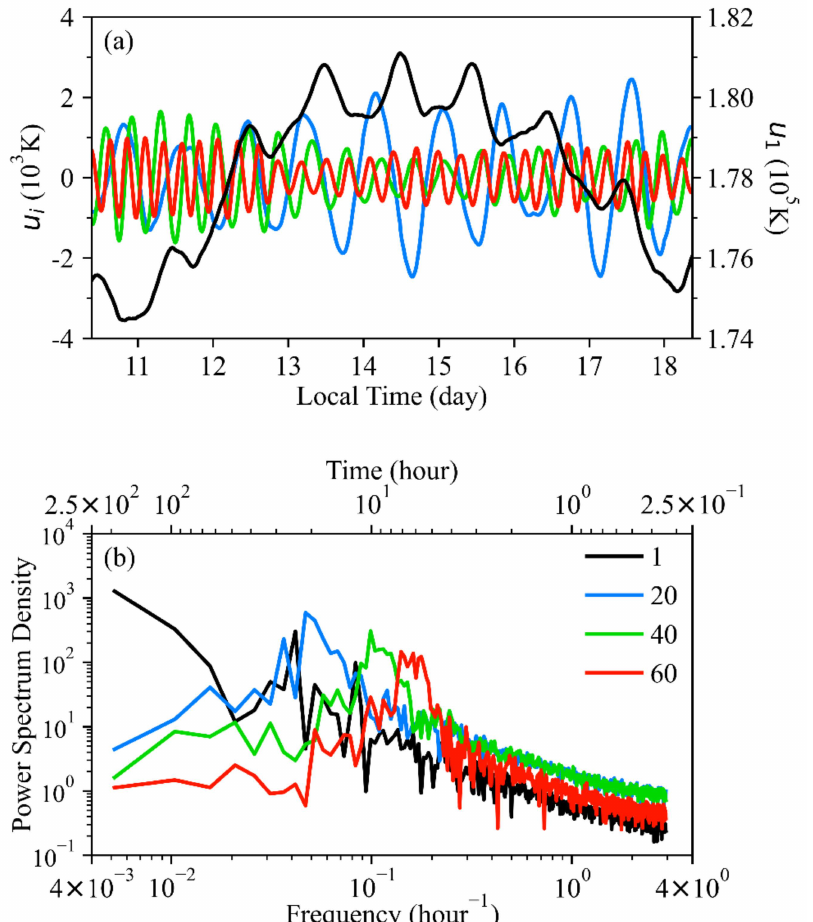
Figure 7. The first (black), 20th (blue), 40th (green), and 60th (red) PC coefficients and their spectra. → u 1 corresponds to the right axis, others correspond to ( a ) shows the values of PC coefficients, where the left axis, and the horizontal axis represents 0000 local time of the corresponding date in May at 135 ◦ E; and ( b ) shows the spectra of these PC